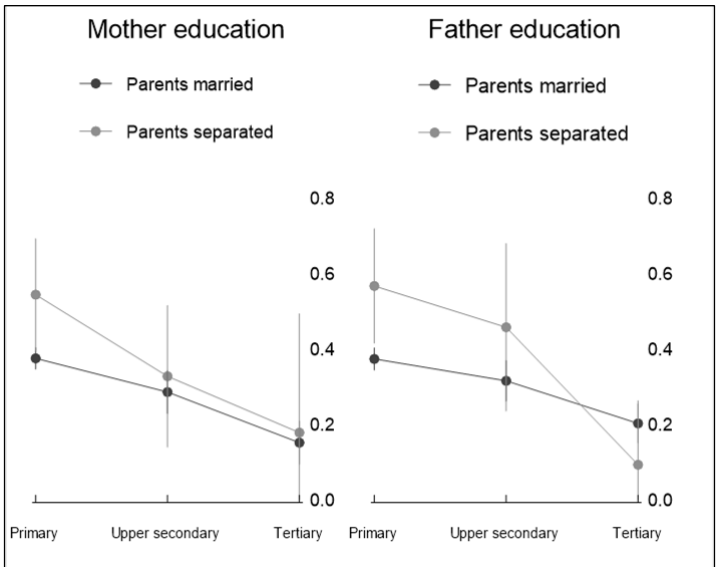
Figure 2 : Predicted probabilities of repeating one year at school